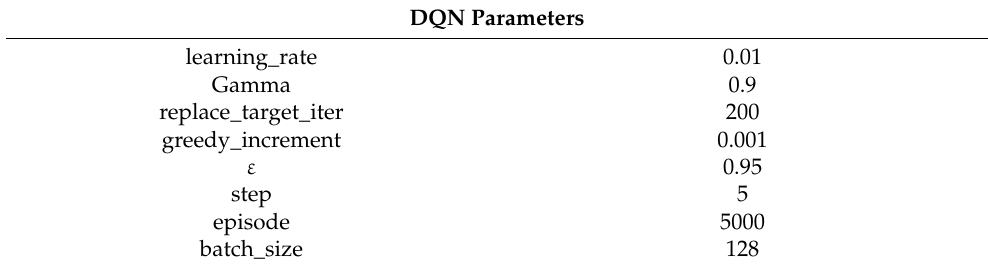
Table 4. DQN parameter table.